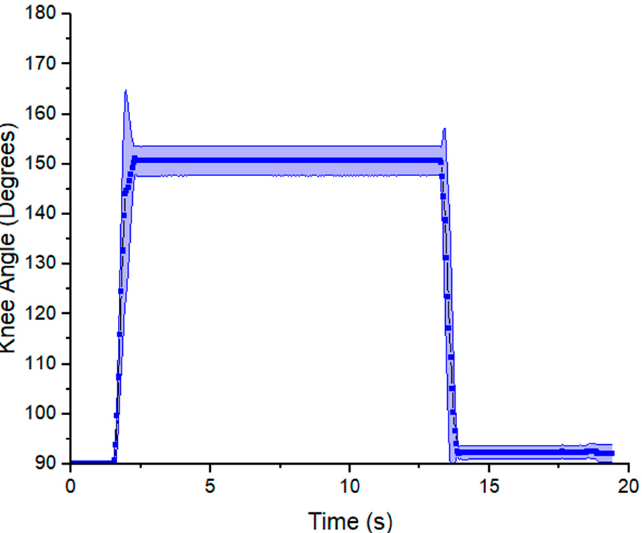
Figure 13. Knee flexion angle over time from model leg experiment in the side-lying position using the C6 H10 and C9 H10 actuators. The same angular nomenclature is used from the previous figure. The value shown is the mean with standard deviation for n = 10 cycles.